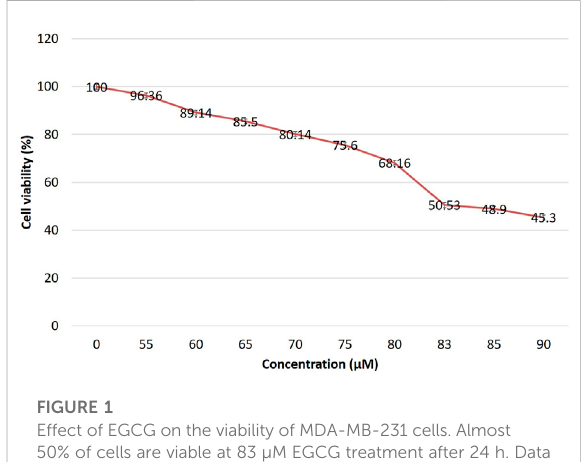
FIGURE 1 Effect of EGCG on the viability of MDA-MB-231 cells. Almost 50% of cells are viable at 83 µM EGCG treatment after 24 h. Data are presented as mean ± SD.